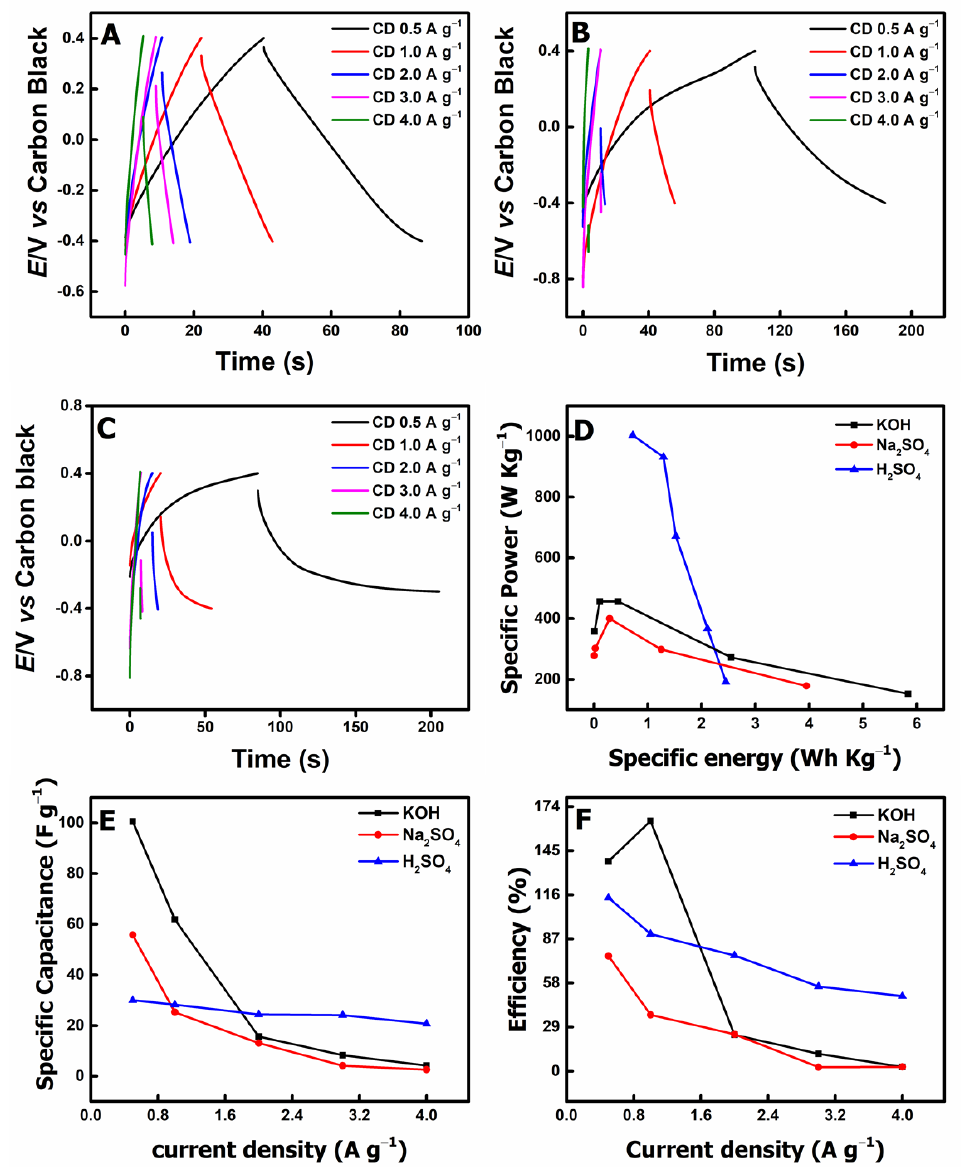
Figure 5. E vs. t plots of CB/CA PCD profiles in 1.0 mol L − 1 ( A ) H 2 SO 4 , ( B ) Na 2 SO 4 , ( C ) KOH, at different CD values: 0.5, 1.0, 2.0, 3.0, and 4.0 A g − 1 . ( D ) SP vs. SE (Ragone plots) for CB/CA in different and equimolar 1.0 mol L − 1 electrolytes: H 2 SO 4 ( (cid:78) ), Na 2 SO 4 ( • ), and KOH ( (cid:4) ). ( E ) Dispersion plot of PCDs SC vs. different current densities (0.5, 1.0, 2.0, 3.0, and 4.0 A g − 1 ) for CB/CA in different and equimolar 1.0 mol L − 1 electrolytes: H 2 SO 4 ( (cid:78) ), Na 2 SO 4 ( • ), and KOH ( (cid:4) ). ( F ) Capacitor efficiency, in equimolar 1.0 mol L − 1 H 2 SO 4 ( (cid:78) ), Na 2 SO 4 ( • ), and KOH ( (cid:4) ), for CB/CA